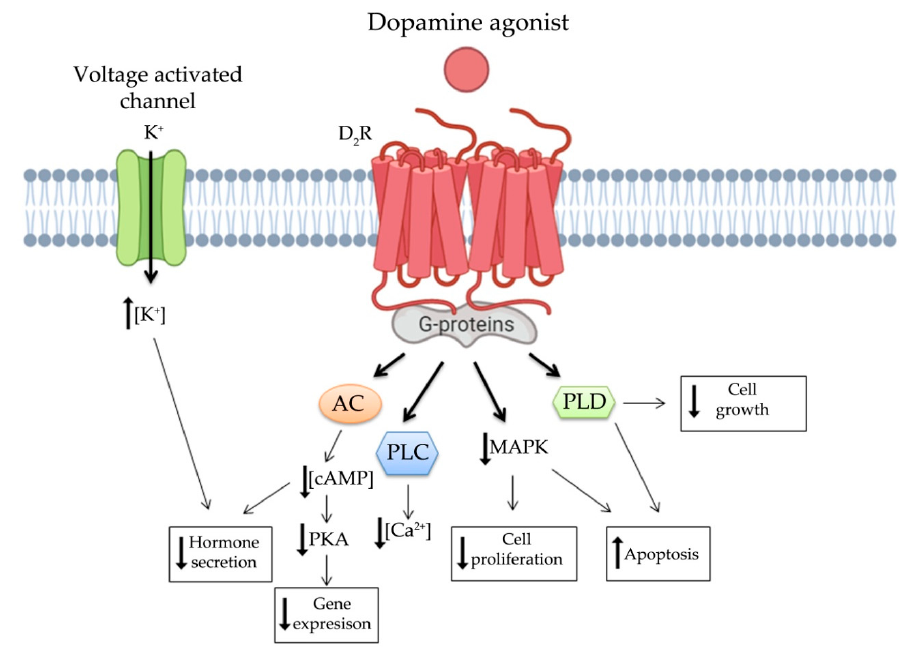
Figure 2. Simplified representation of D2 signaling. Dopamine and DA binding to D2R, via interaction with G proteins, inhibit AC activity and phosphatidylinositol metabolism, activate voltage-activated potassium channels and decrease voltage-calcium currents, and modulates the activity of PLC, PLD, and MAPKs. These processes result in decreasing hormone secretion and cell proliferation. AC, adenylyl cyclase; PLC, phospholipase C; MAPK, mitogen-activated protein kinase, PLD, phospholipase D; cAMP, cyclic adenosine monophosphate and PKA, protein kinase A.